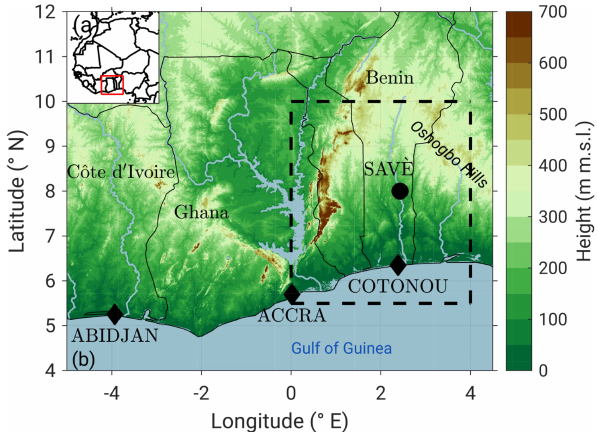
Figure 1. Location of the investigation area (red box) in southern West Africa (a) and topography in the investigation area with the location of the supersite Savè (Benin) and of the coastal radiosonde stations at Abidjan (Côte d’Ivoire), Accra (Ghana) and Cotonou (Benin) indicated (b) . The hashed box indicates the area used for the analysis of the spatial distribution of LLC. Solid lines indicate country borders with country names given in (b)